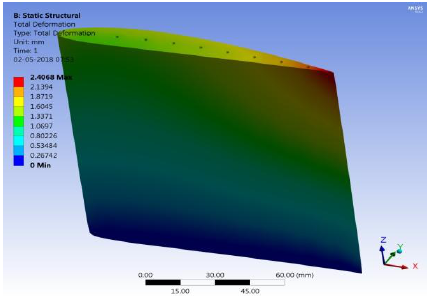
Figure 6 : Deformation for nimonic with 9 cooling holes The maximum deformation is obtained at tip of blade that is green at leading edge and very high at trailing edge which is red. Minimum at root of blade which is blue colour in above